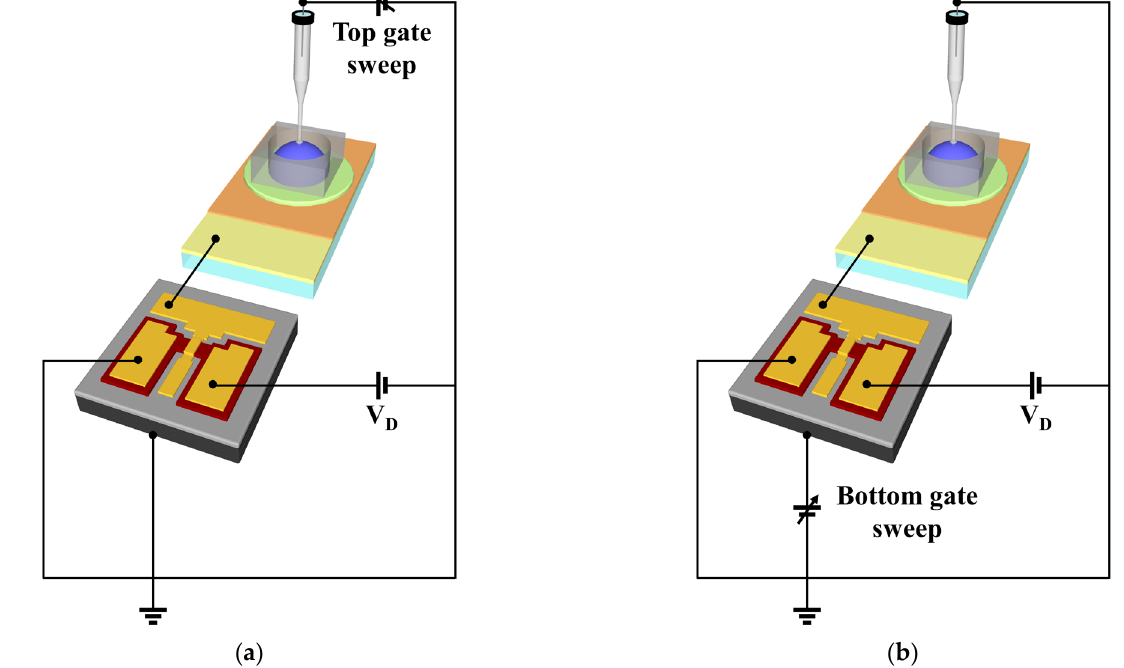
Figure 4. Schematic of the ( a ) SG mode and ( b ) DG mode sensing